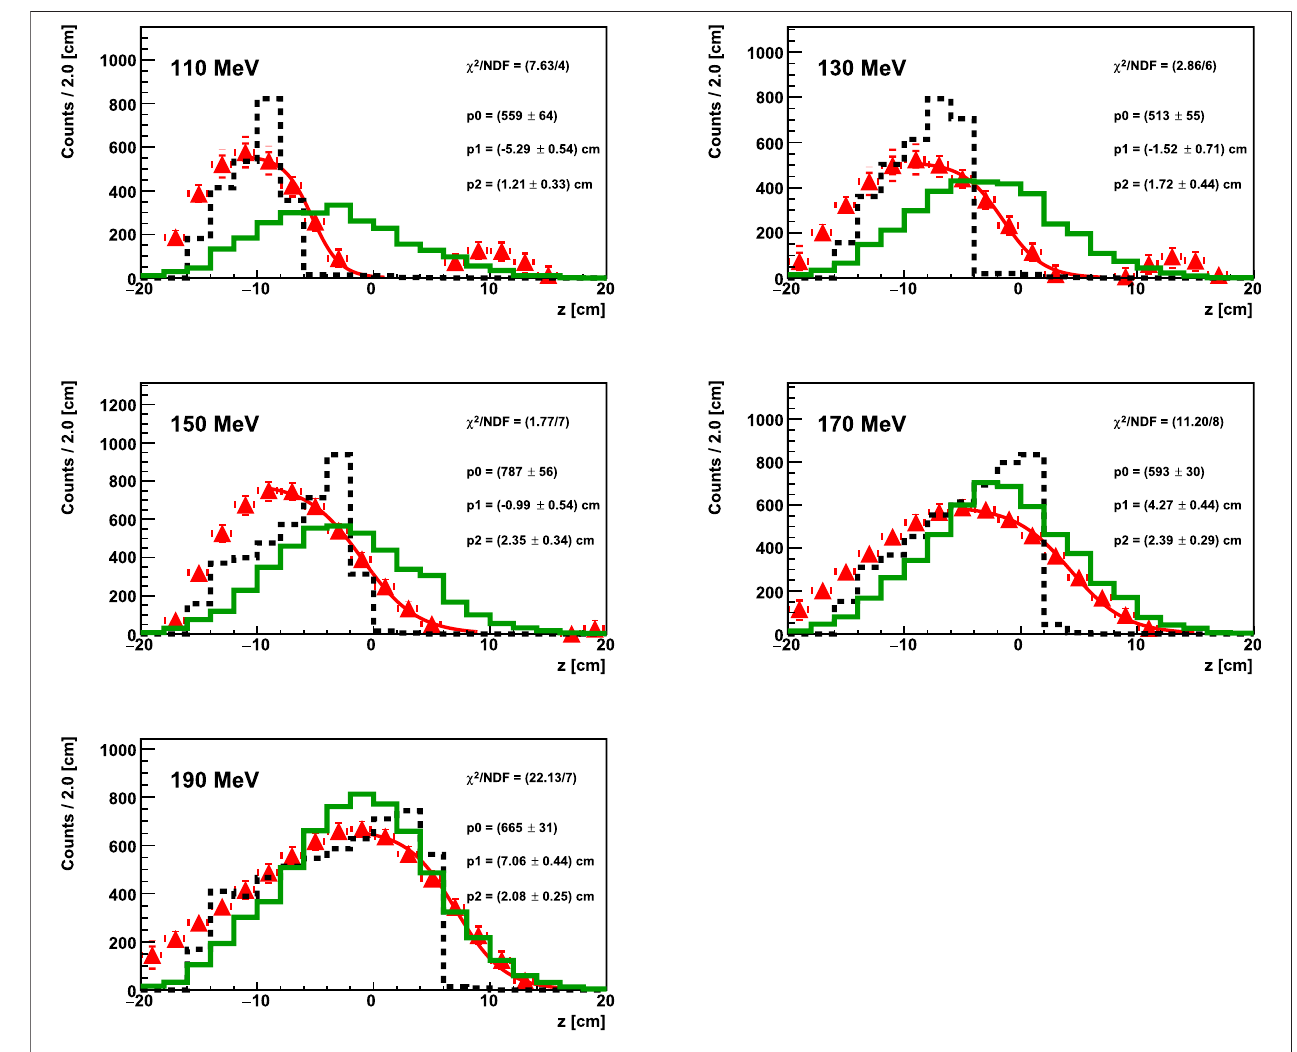
FIGURE13| Truephotonemissiondistribution(dottedblackline)superimposedtotherawreconstructedpromptphotonsemissionspectrum(solidgreenline)and to the unfolded distributions (red triangles) for the FULL simulations of protons (10 11 primaries) at different energies impinging on a PMMA target. The geometrical setup of the simulations is the one shown in Figure 6 . The fi t on the unfolded distributions is performed with the function in Eq. 2 and the fi t parameters are reported on each canvas.